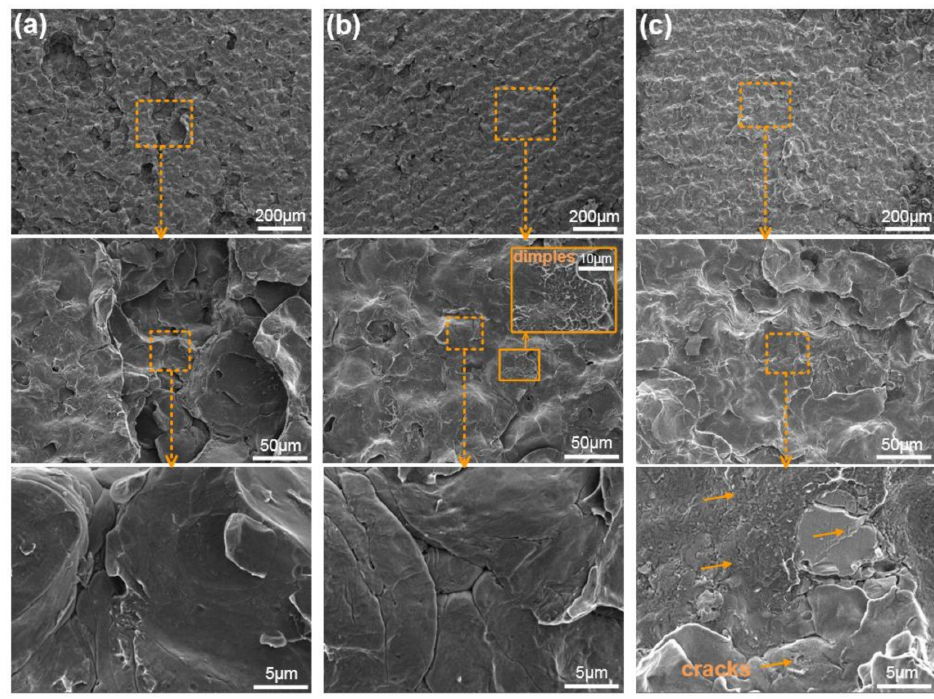
Figure 6. Fracture morphology. ( a ) Sample #0, ( b ) sample #1, ( c ) sample